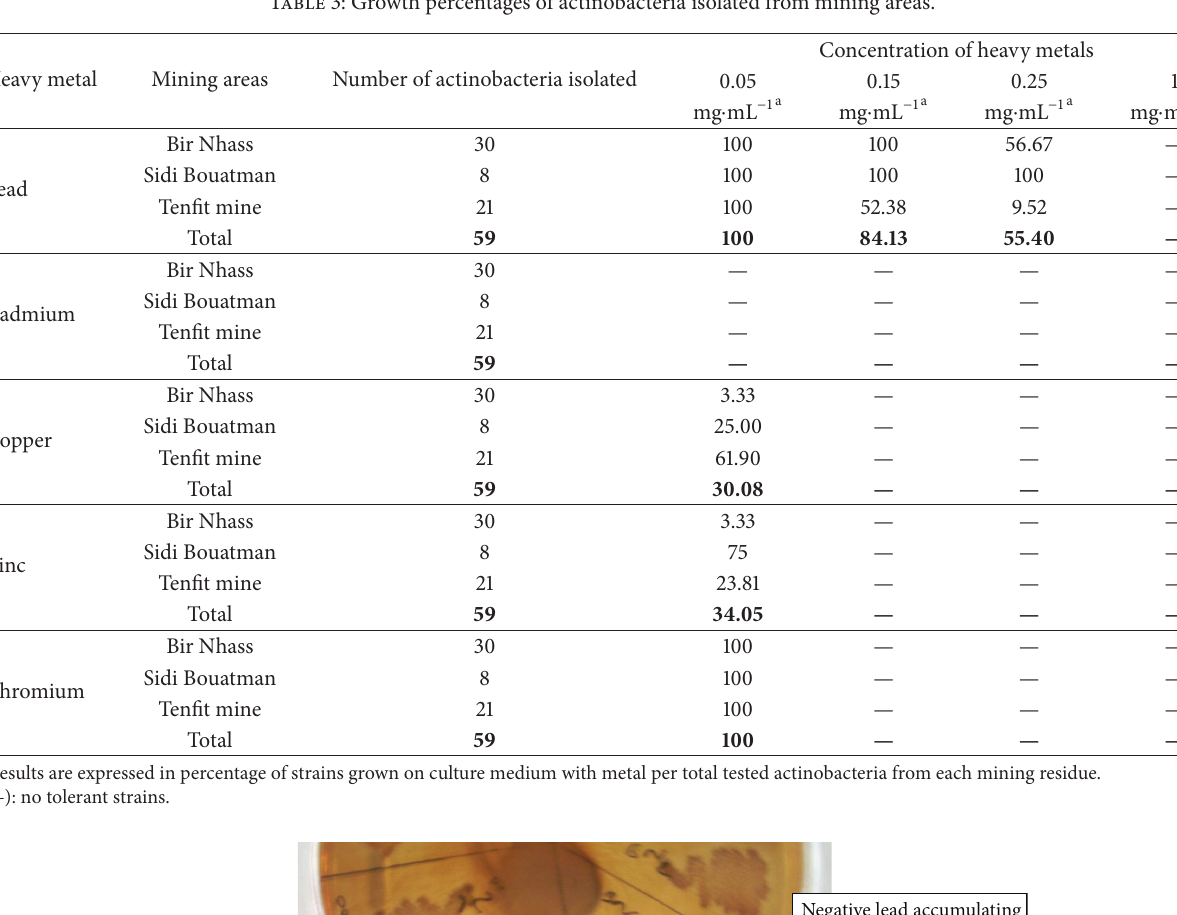
Table 3: Growth percentages of actinobacteria isolated from mining areas.